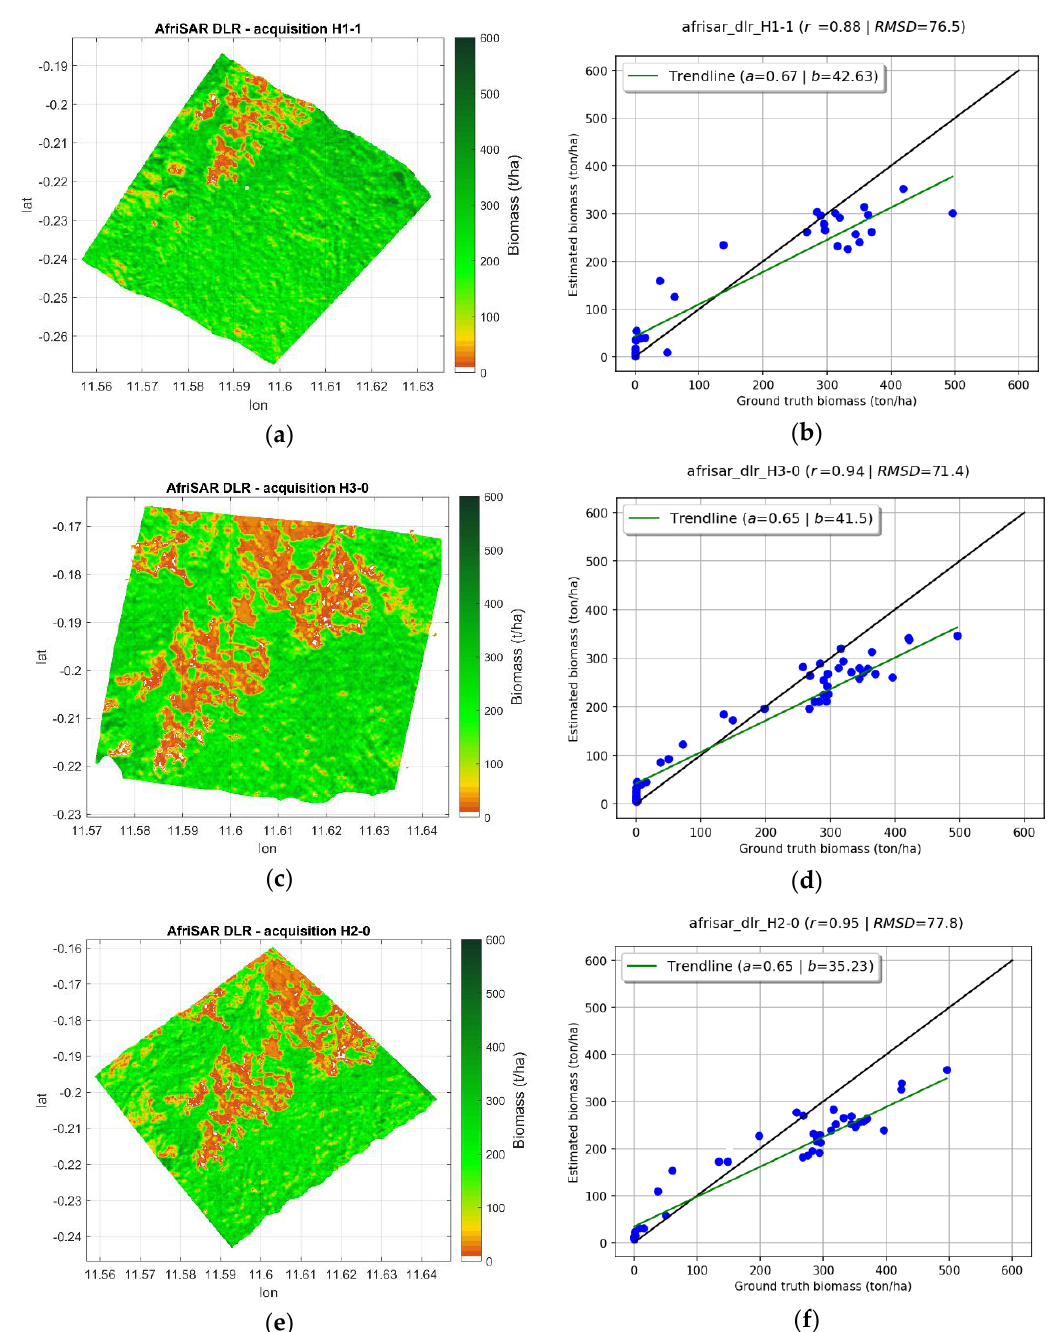
Figure 7. Examples of biomass maps estimated from AfriSAR DLR SAR images by using ( a , e ) the ANN algorithm and ( c ) the SVR algorithm. In ( b , d , f ) are shown the corresponding validation scatterplots.